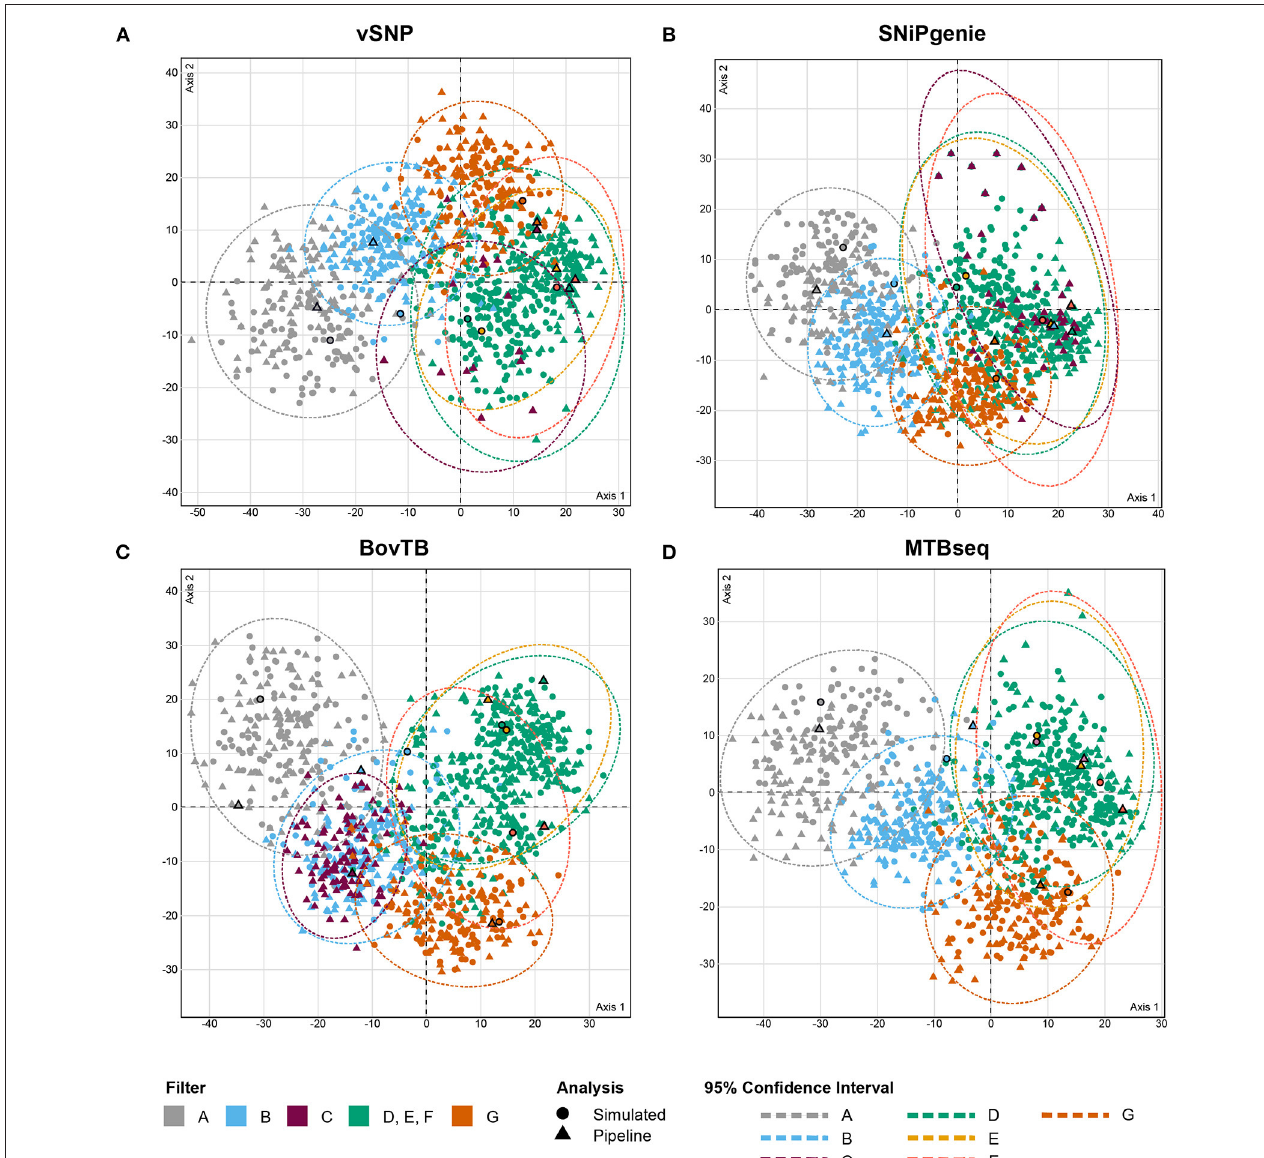
FIGURE 5 | MCA analysis of the RF distances (first two dimensions) between maximum likelihood (ML) trees obtained from core SNP multi-FASTA alignments produced by (A) vSNP, (B) SNiPgenie, (C) BovTB, and (D) MTBseq. Shapes without outlines correspond to bootstrap replicates whereas bold shapes correspond to the best ML trees output by RAxML. Color shading corresponds to the hard filtering approach